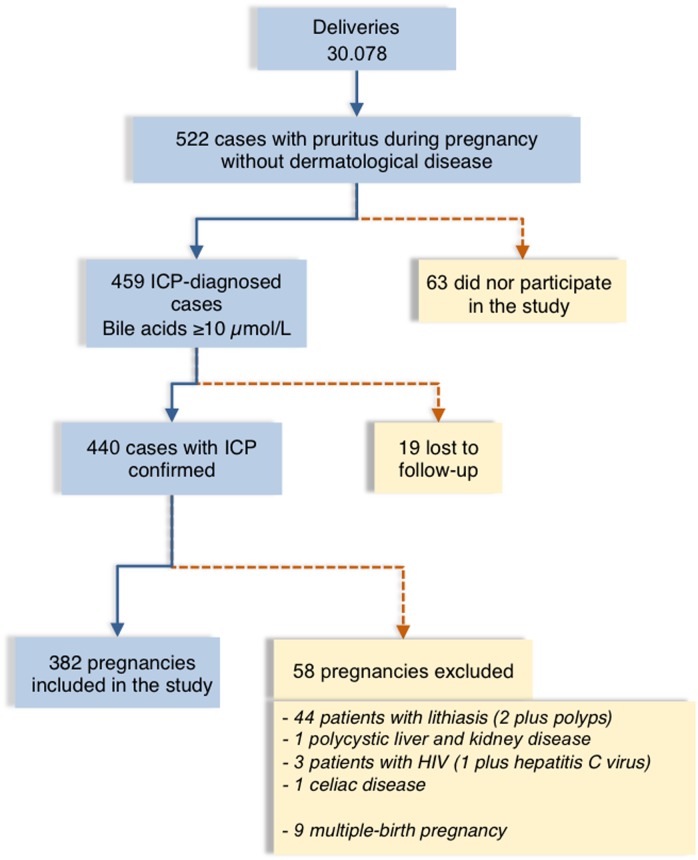
Flow chart of ICP cases included in the study.Flow chart showing the intrahepatic cholestasis of pregnancy (ICP) cases at the Mother’s and Children’s Hospital, Buenos Aires, from June 2009 to December 2013, and reasons for the exclusion of some patients from the study.